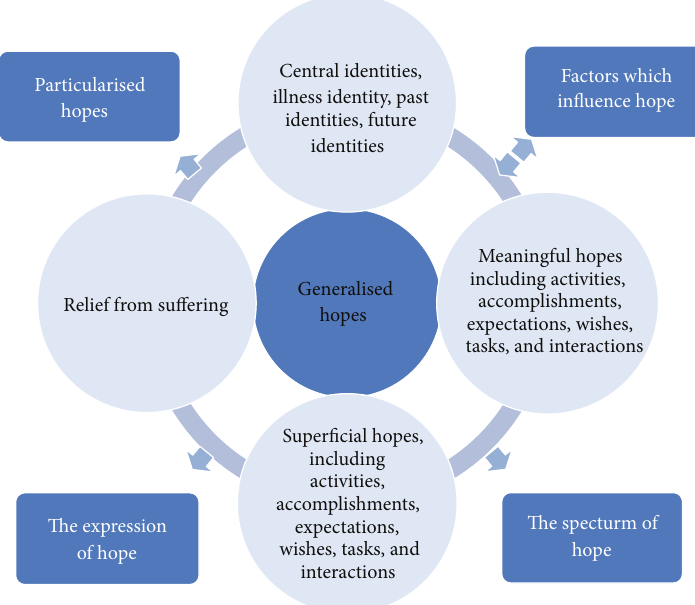
Figure 1: Illustrating the framework of